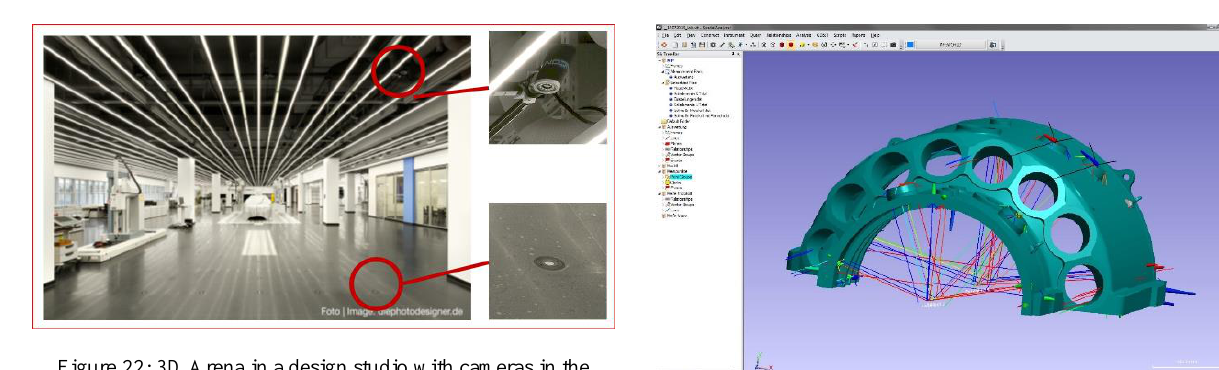
Figure 22: 3D Arena in a design studio with cameras in the ceiling and reference marks on the floor